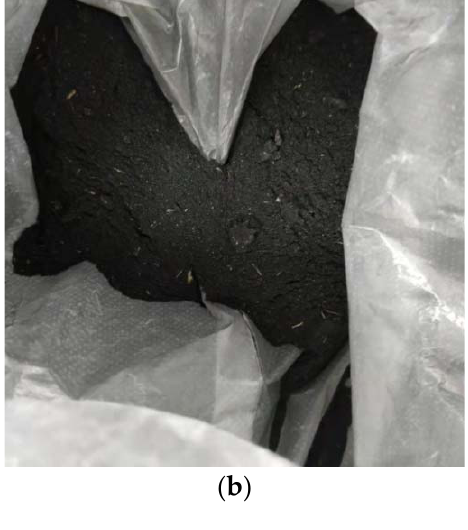
Table 2. Mix design of BA ‐ MPC mortars composites (kg/m 3 ).